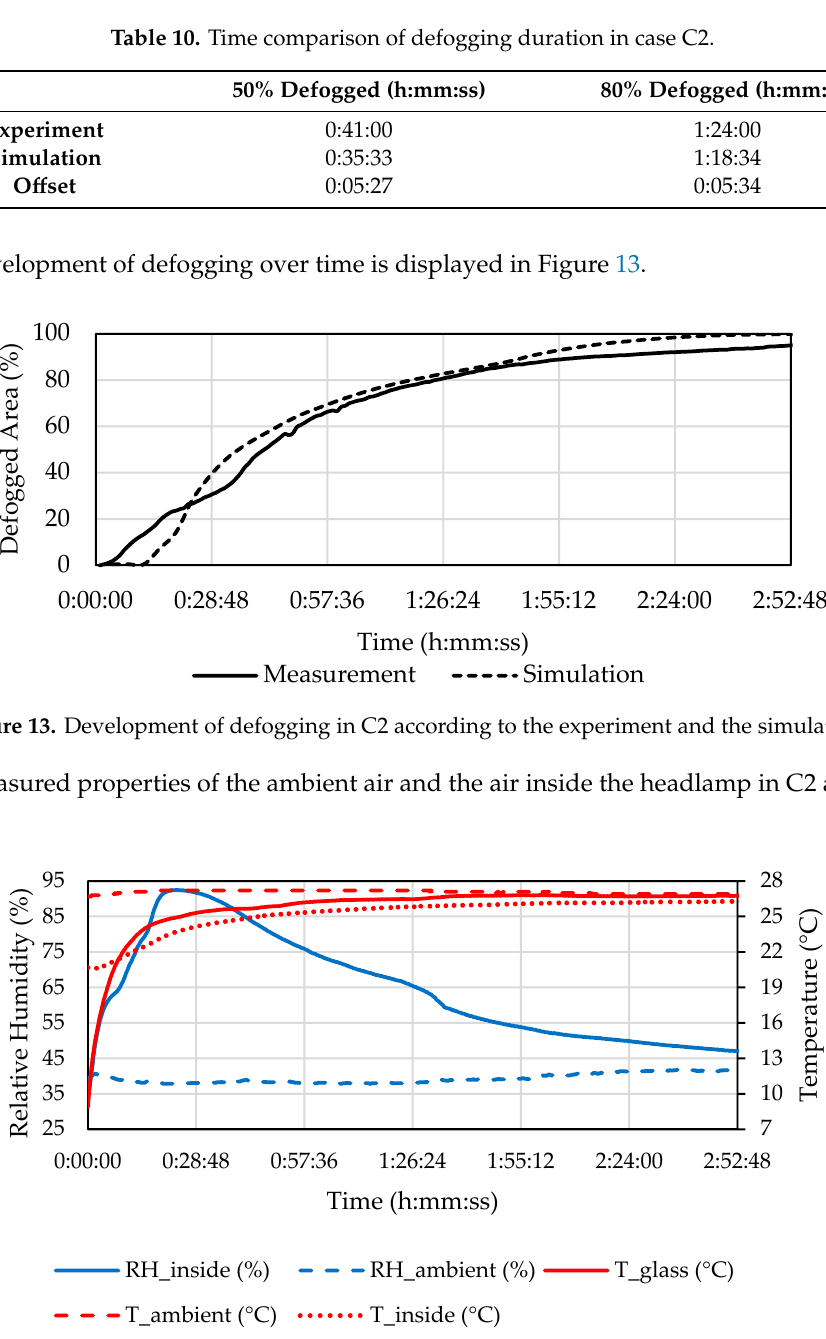
Figure 14. Temperature and relative humidity of the ambient air and inside the headlamp and temperature of the front glass during the C2 defogging phase.